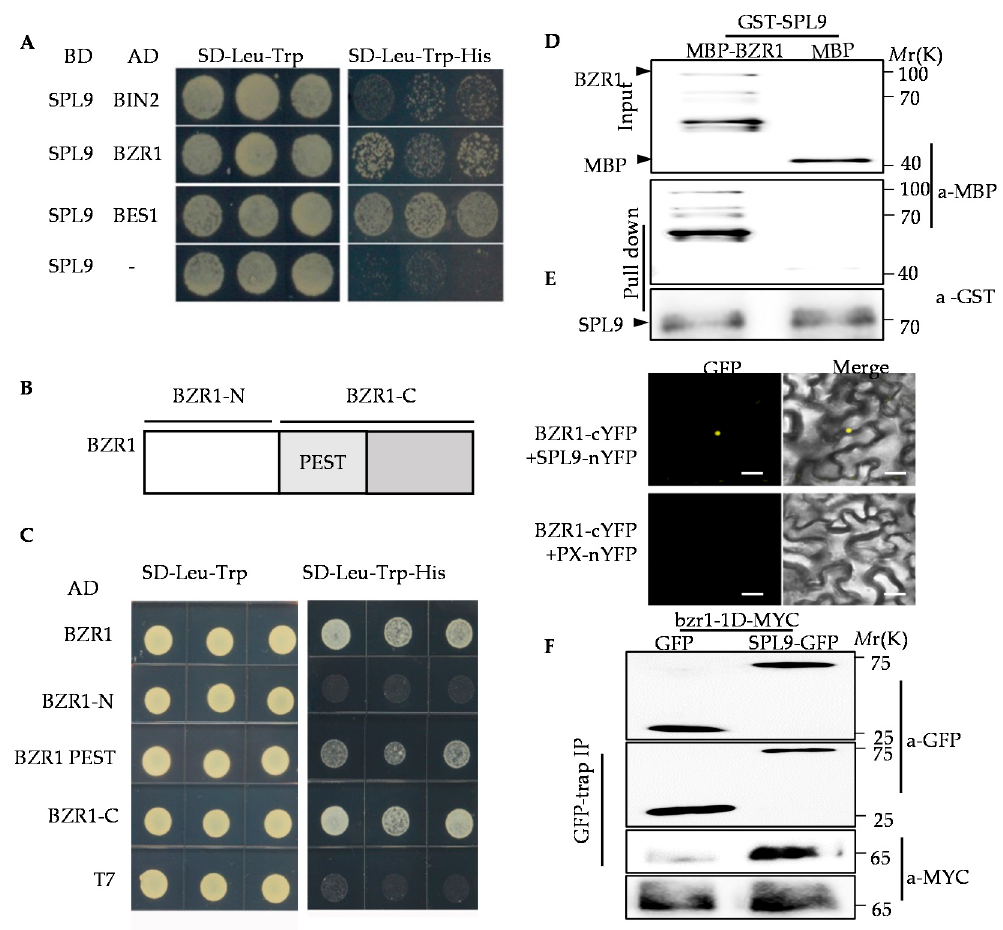
Figure 1. BZR1 interacts with SPL9 in vitro and in vivo. ( A ) SPL9 interacted with BZR1, BES1, and BIN2 in yeast. AD means activation domain; BD means DNA binding domain; SD means Synthetic dextrose minimal medium. ( B ) A diagram of the structure of BZR1. ( C ) The C-terminal of BZR1 was required for the interaction between BZR1 and SPL9 in yeast. PEST means the PEST domain. ( D ) Maltose binding protein (MBP) or MBP-BRASSINAZOLE RESISTANT 1 (BZR1) protein were incubated with glutathione-agarose beads combining glutathione S transferase (GST)- SQUAMOSA PROMOTER BINDING PROTEIN-LIKE9 (SPL9) and then eluted and analyzed by anti-MBP and anti-GST immunoblot- ting. ( E ) BiFC assays showed the interaction between BZR1 and SPL9 in plants. GFP means the green fluorescent protein. ( F ) BZR1 interacts with SPL9 in vivo. Immunoprecipitation (IP) was performed using Arabidopsis protoplast